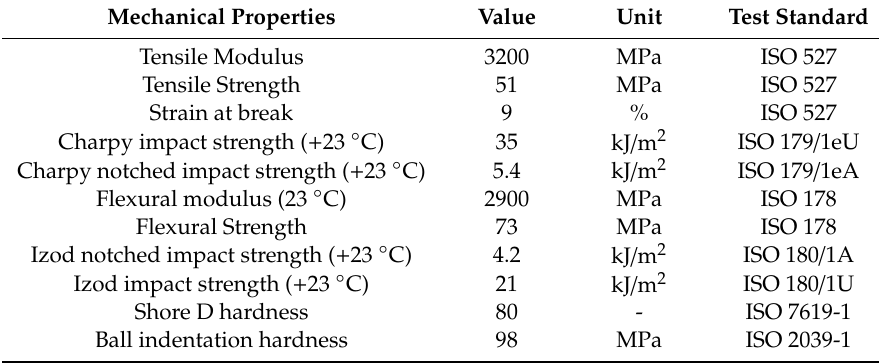
Table 1. Mechanical Properties of PA 3200 GF